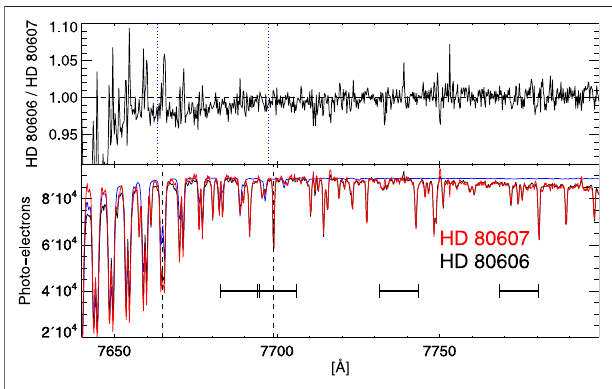
FIGURE 2 | WIYN Hydra spectrum of HD 80606 during the center portion of an HD 80606b transit (black). A HD 80607 spectrum has been scaled to match dynamic range (red). Modelled telluric transmission is shown in blue, scaled to the continuum around K D1. The tunable fi lter bandwidths sampled by Colón et al. (2012) are shown as black bars. Black dashed lines indicate wavelengths of the stellar potassium D lines. The top panel shows the ratio of HD 80606/HD 80607, where blue dotted delineates potassium lines blue-shifted by the eccentric planetary orbital